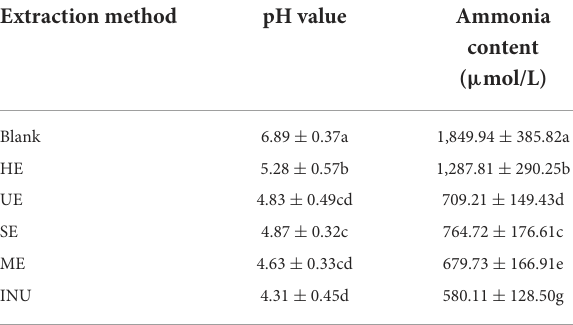
TABLE 1 Analysis of pH and ammonia content of in vitro fermentation samples.